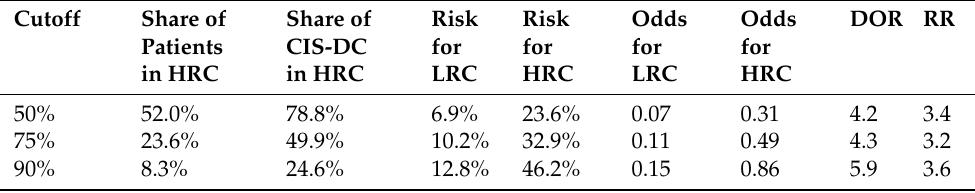
Figure 8. Boxplots of expression levels of selected markers comparing samples with CIS in disease course and those without it. Values of “DPY19L3-DT” are presented after applying a logarithm operation to be able to show the difference. Others are plotted verbatim. It can be seen that low expression levels of ADAM28 and TMEM232 increase the risk of CIS in disease course, while the 5 other variables exhibit the inverse behavior. Table 3. Externally cross-validated results for the Random Forest classifiers. The first column defines the threshold set in the classifiers, separating low- and high-risk groups. The second column displays the fraction of all patients assigned to a high-risk class (HRC) at a given threshold. Analogously, the third column presents the fraction of all CIS-DC cases assigned to the high-risk class. Two next columns present the fraction of CIS-DC in a low- and high-risk class (LRC and HRC), respectively. Similarly, columns six and seven present the odds of CIS-DC in an LRC and HRC, respectively. Finally, the DOR column displays the diagnostic odds ratio between the HRC and LRC, and RR displays the risk ratio between these classes. The comment on the cutoff and share of patients in the HRC from Table 4 applies here as